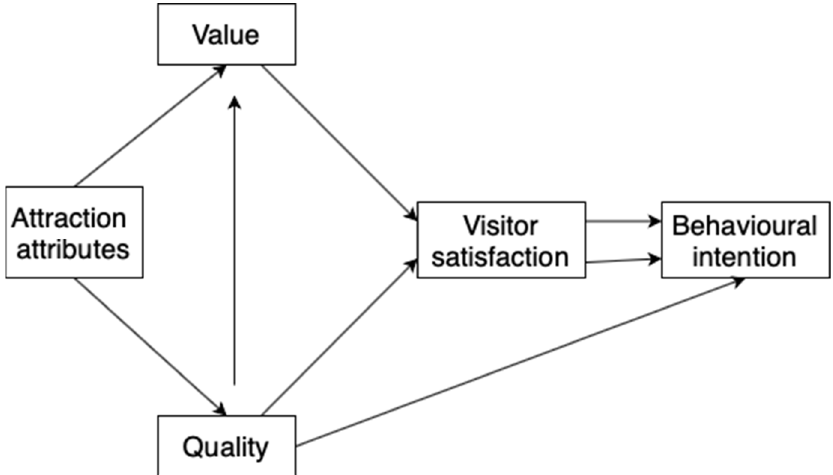
Figure 1. Service quality, value, satisfaction, and behavioral intentions model [19].